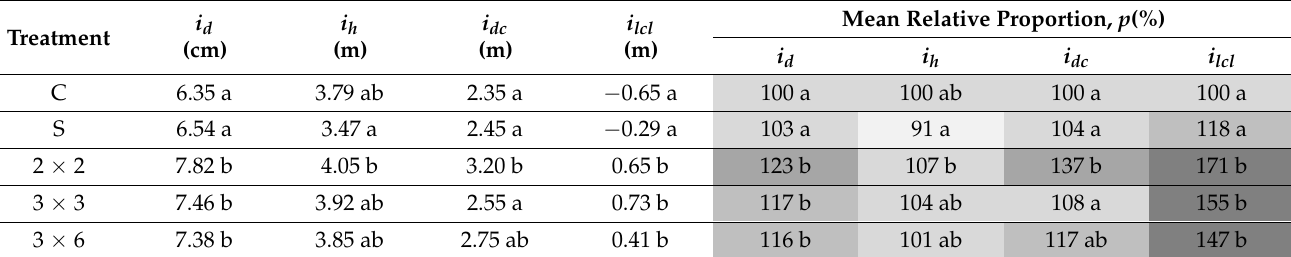
Table 2. Mean increment for tree diameter ( i d ), tree height ( i h ), mean crown diameter ( i dc ), and live crown length ( i lcl ) in the period of 1995–2015. Mean relative proportion ( p(%) ) in relation to the control plot of Pyrenean oak coppice. The same letter in the column indicates the group subset and nonsignificant differences from the mean comparison test, at the 5% significance level. Different box-filled colors represent relative